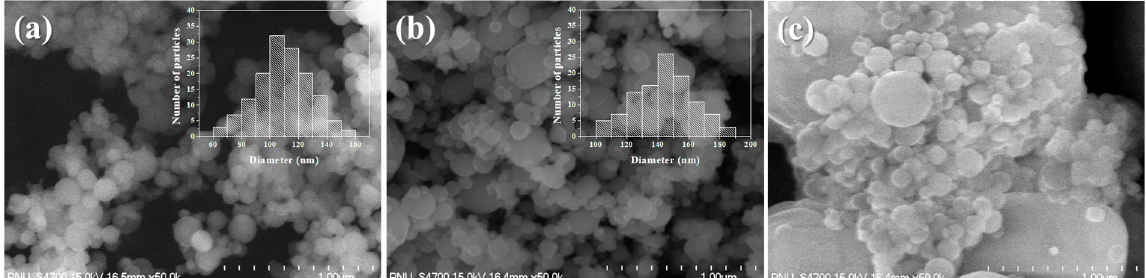
Figure 2. FE-SEM images of ( a ) Al NPs, ( b ) CuO NPs, and ( c ) PEO/nEM composites (PEO:nEMs = 10:90 wt.%).